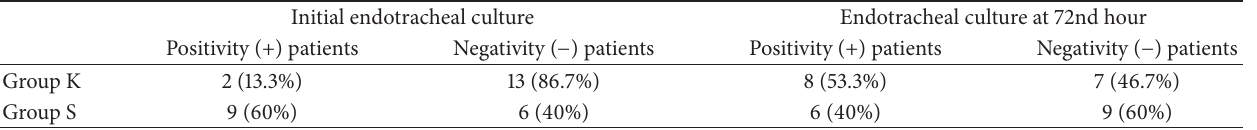
Table 4: The results of endotracheal